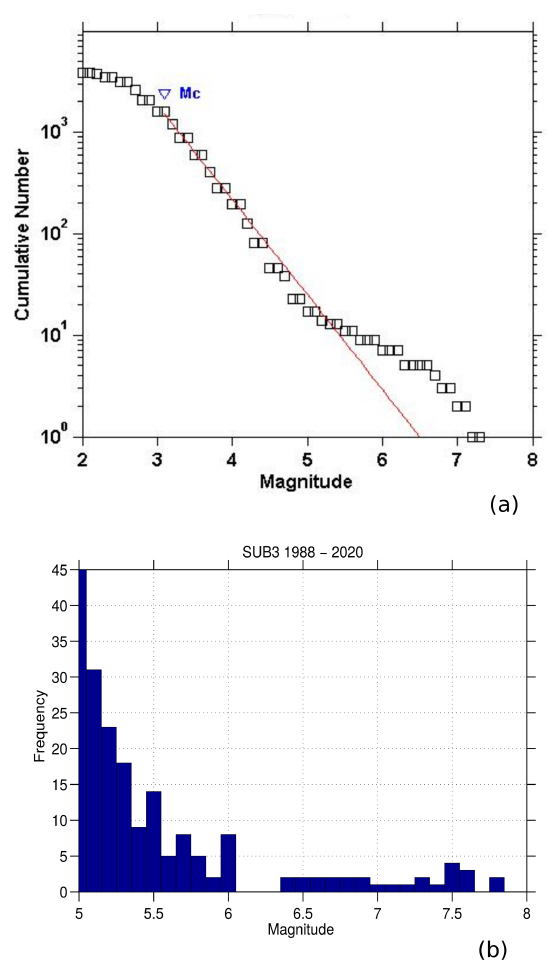
Figure 2. (a) Frequency–magnitude distribution of events occurred in the SUB3 seismic region after 1988–2014 (Zúñiga et al., 2017). (b) Magnitude histogram for M > 5 . 0 from 1988 to